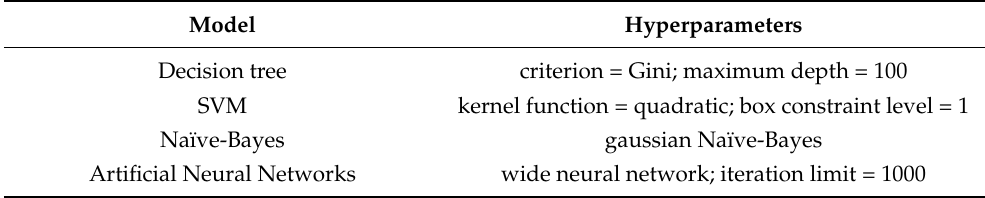
Table 1. Parameters used for classification